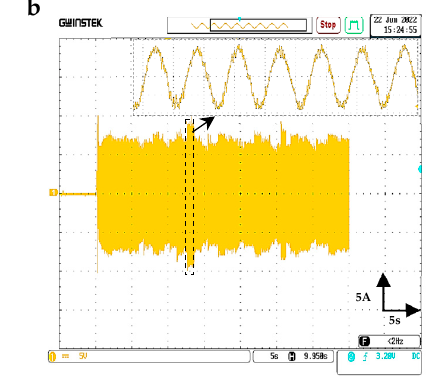
Figure 21. Stator phase current for speed profile 1 and 2. The flux magnitude and components are shown in Figures 22 and 23, respectively.